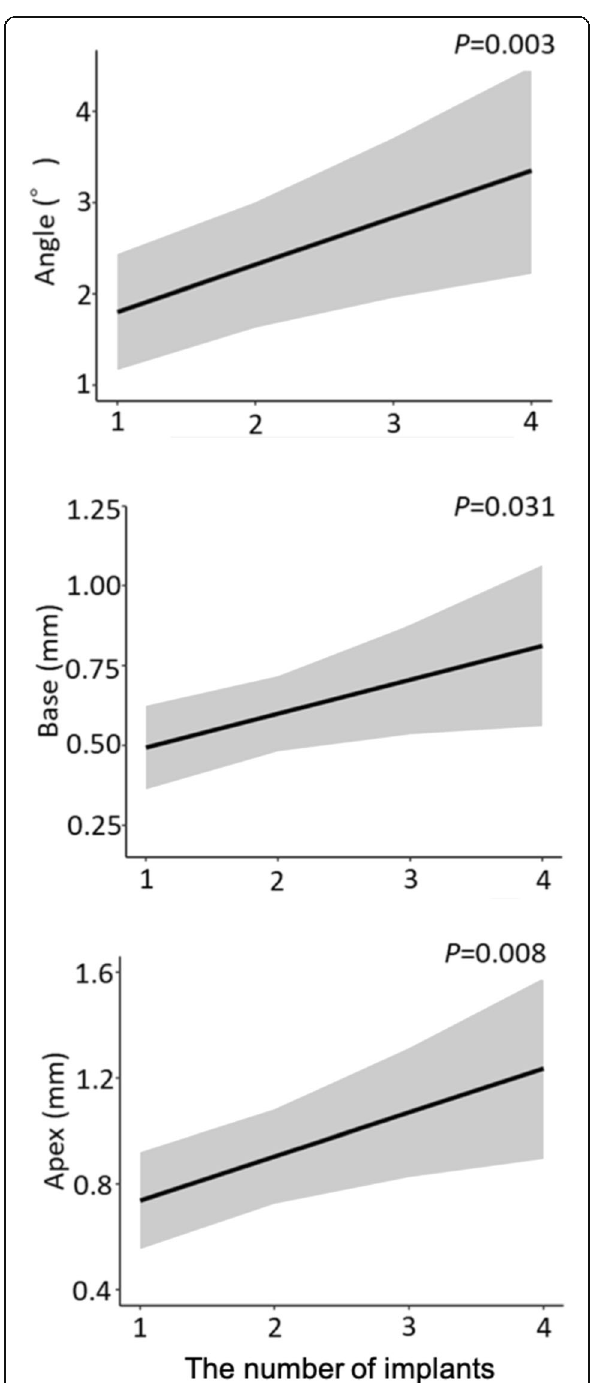
Fig. 11 The errors caused by differences in the number of implants. The shaded area shows 95% confidence